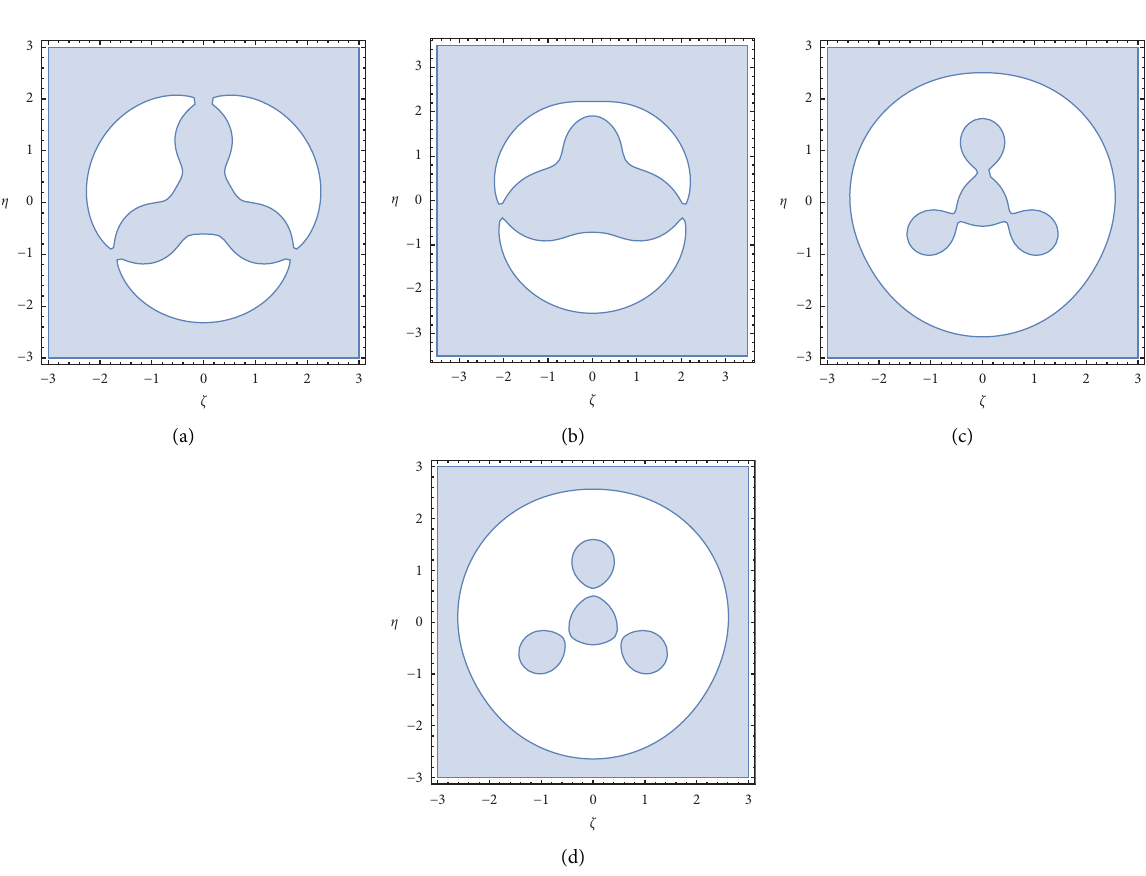
when μ � 1 . 73878 (a) C � − 5 . 23, (b) C � − 5 . 25, (c) C � − 6 . 39, (d) C � − 7 . 505. 5